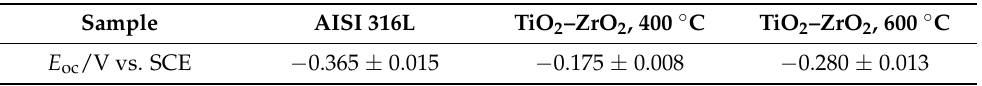
Table 2. Values of open-circuit potential ( E oc ) measured in 3 wt% aqueous NaCl solution (mean value ± standard deviation).